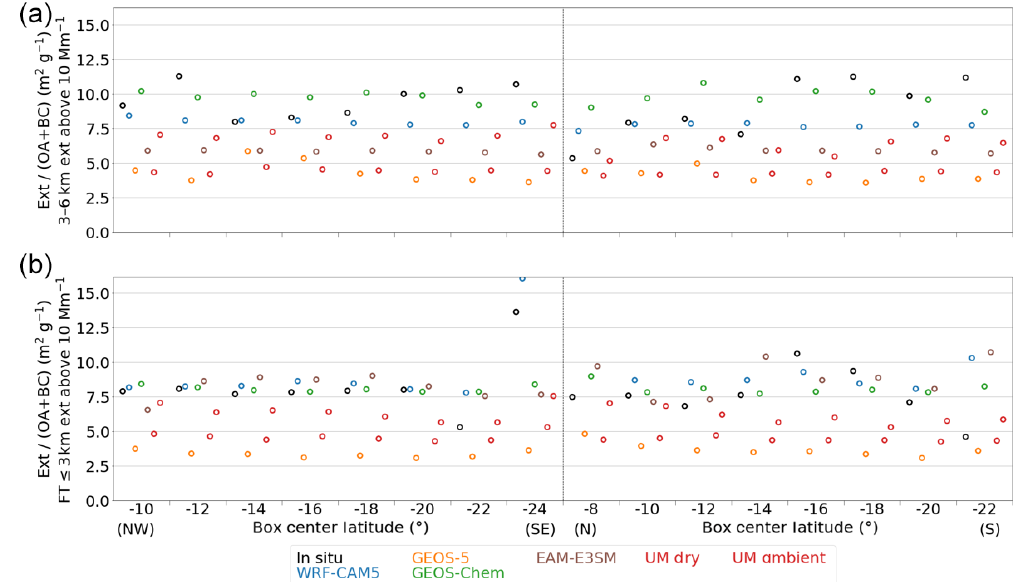
Figure 15. The ratio of extinction to the sum of organic aerosol and black carbon masses, computed for box mean values. The in situ observation of extinction is for dried particles, while the models refer to ambient humidity conditions except for UM dry. Panels (a, b) are for 3–6km and for the top of boundary layer to 3km,